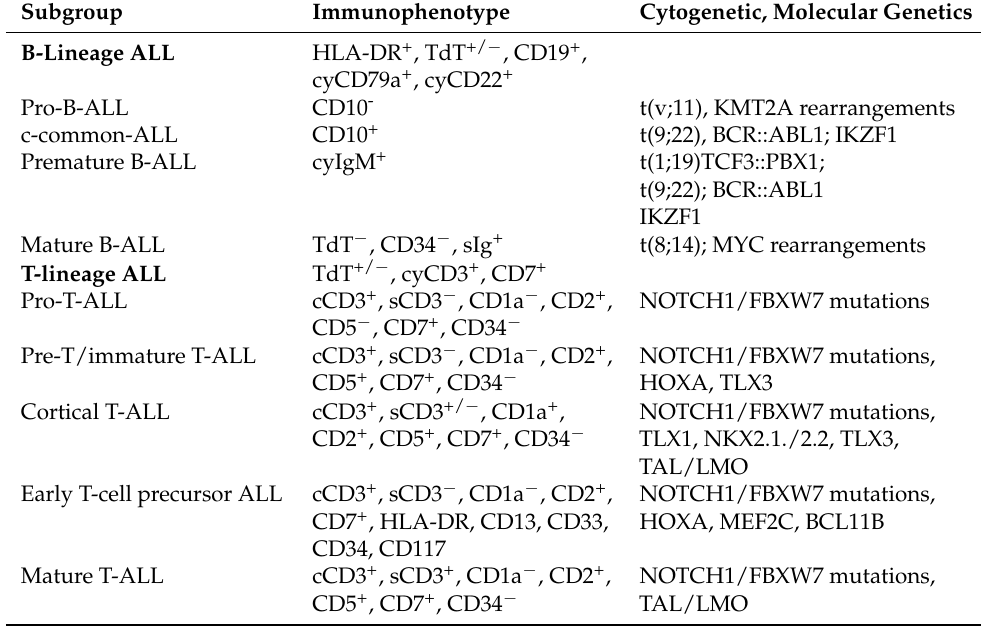
Table 1. Subgroups in adult